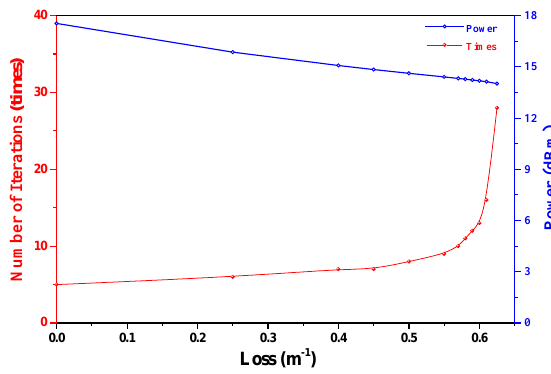
Figure 5. Iterative times and output power versus additional loss.